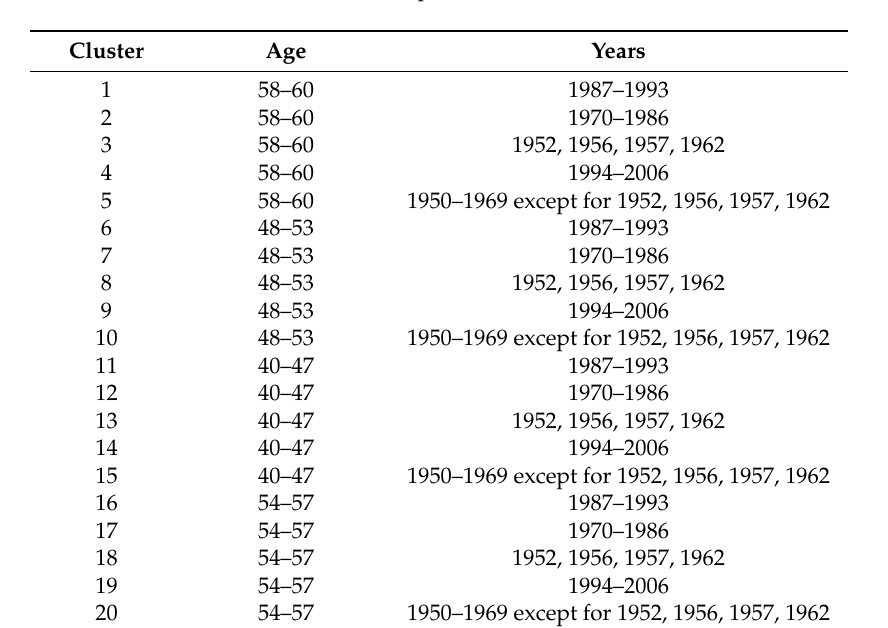
Figure 5. Biclusters 11–20. Table 1. The composition of biclusters.